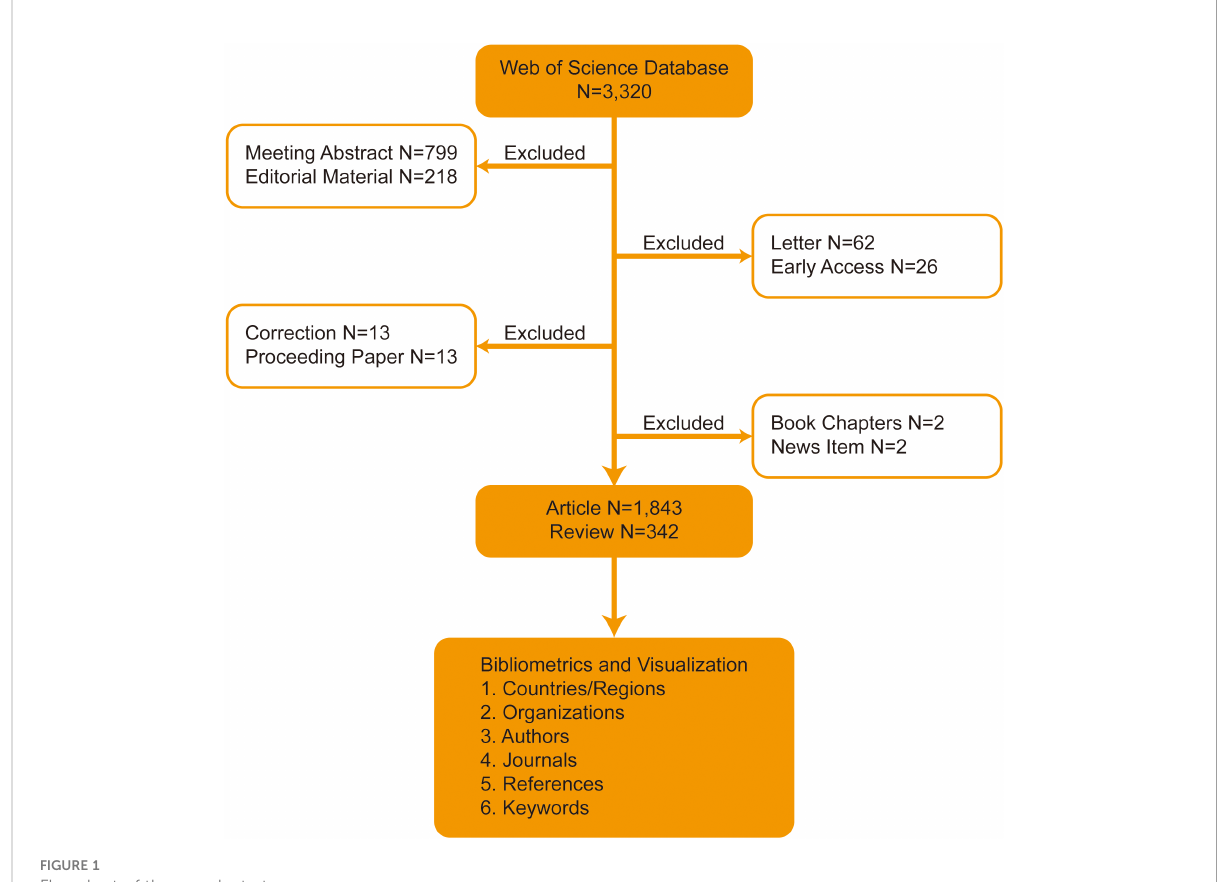
FIGURE 1 Flowchart of the search